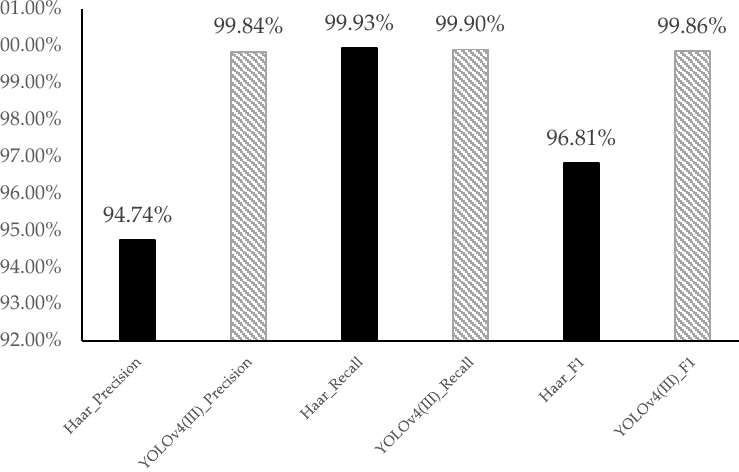
Figure 10. Negative performance for the average of precision, recall, and F1 with 191 videos.